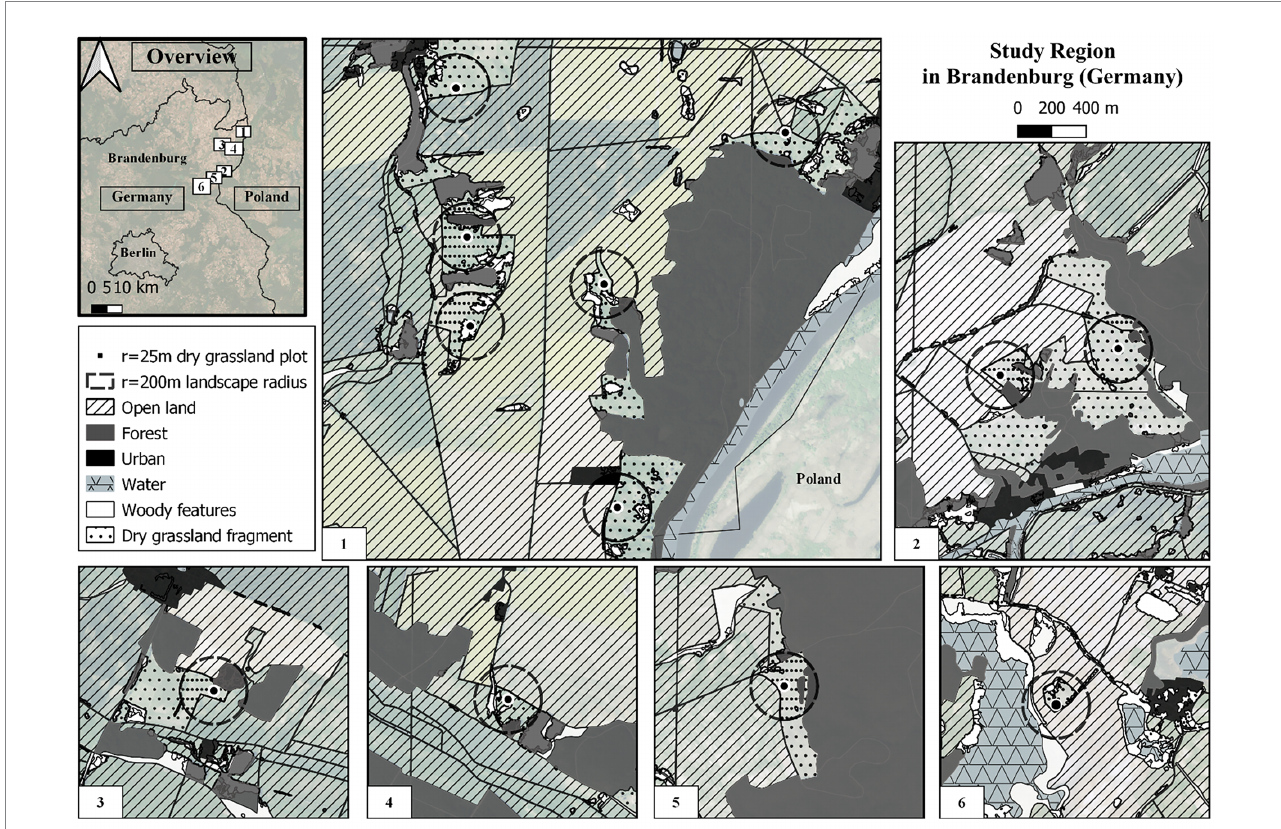
FIGURE 1 Map of study region in Brandenburg in Germany with the landscape types, locations of the dry grassland plots ( n = 12) and the landscape radii for